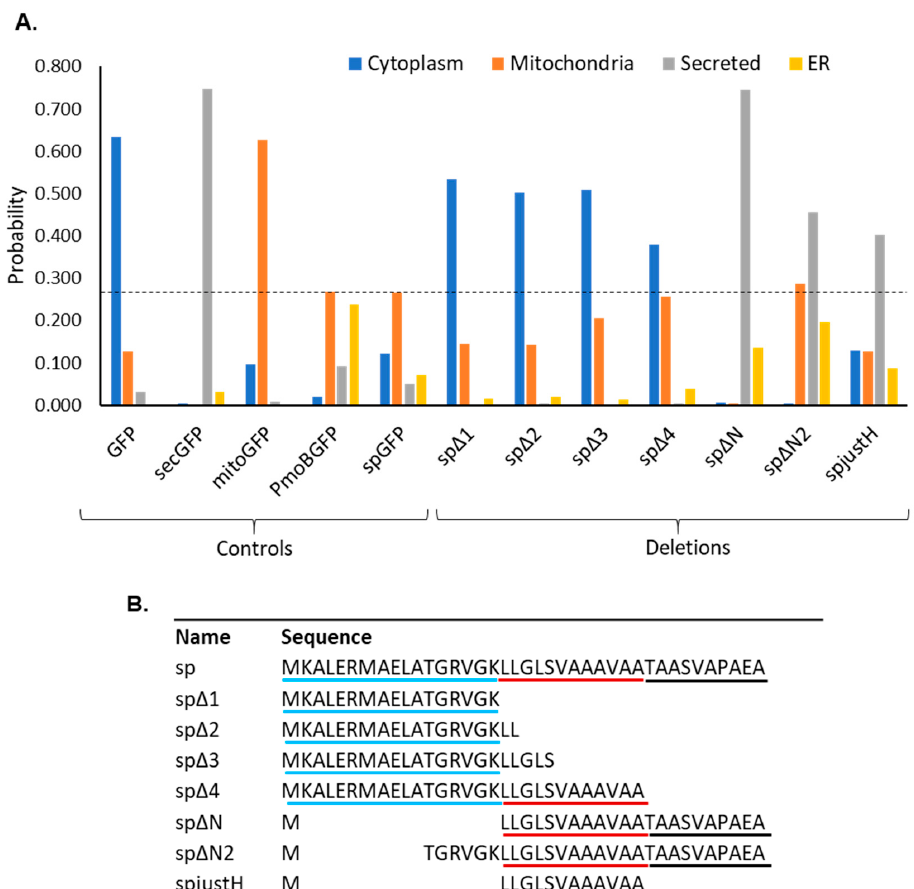
Figure 3. Subcellular localisation prediction of deletions of the PmoB signal peptide. ( A ) Probability of subcellular localisation in each compartment using MULocDeep, for control sequences and deletions of the signal peptide. Probabilities for the four predominant compartments in all cases are shown (cytoplasm, mitochondria, secreted and ER). The dotted line marks the mitochondrial probability of the native signal peptide fused to GFP (spGFP). ( B ) Sequence of the native signal peptide (sp) and all the mutants analysed in MULocDeep. The sequences are aligned to show the position of the deletions; n-, h- and c-regions are underlined in blue, red and black, respectively.